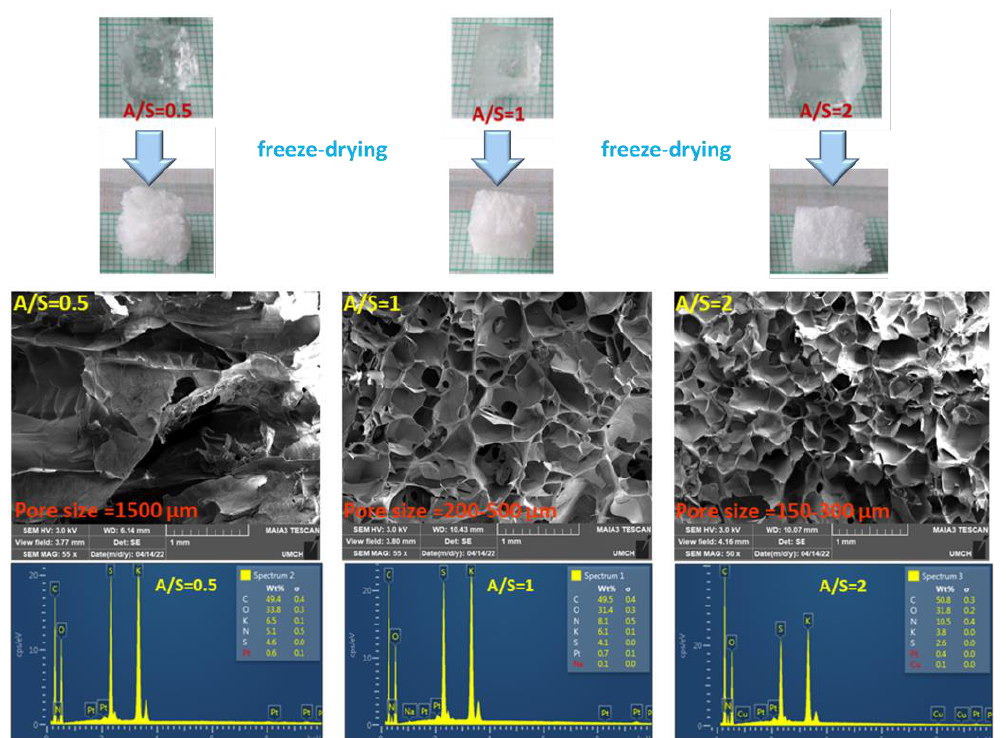
Figure 1. The prepared HPMC-g-poly(AM-co-SPA) hydrogels before and after freeze-drying; SEM images of their porous morphology; and the EDX elemental analysis of these hydrogels.